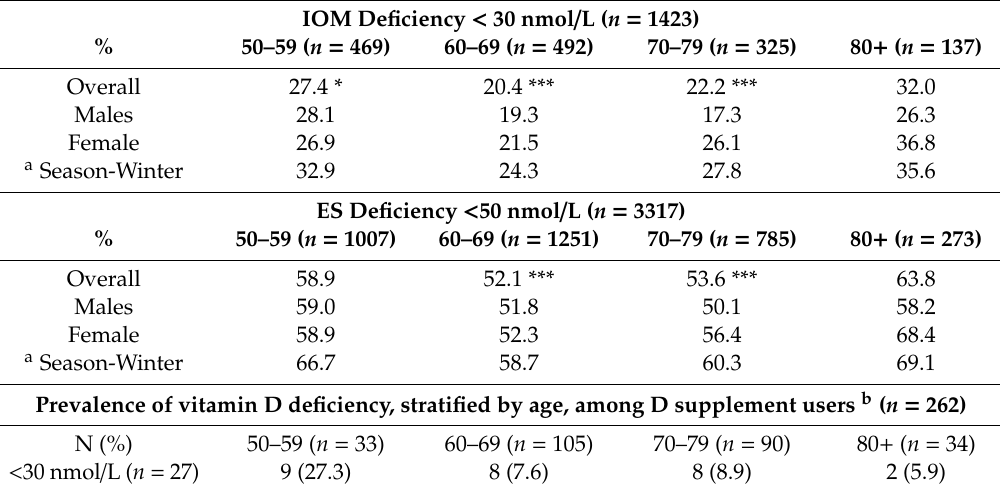
Table 2. Prevalence of vitamin D deficiency, stratified by age and sex ( n =